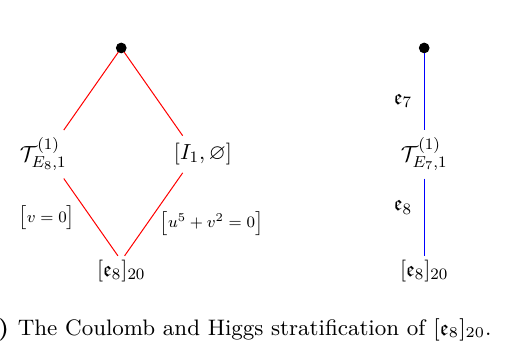
Figure 2. Information about the [ e 8 ] 20